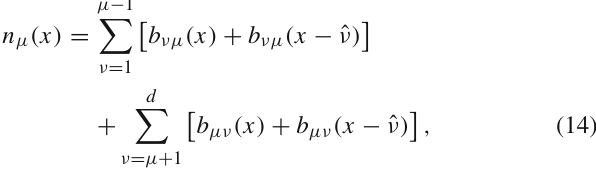
Fig. 1 Representation of the (μ 0 ,ν 0 ) lattice plane. The gauge links ( x ) = U are shown as arrows. The “central plaquette” U μ 0 1 U 2 U 3 U 4 0 ν 0 (in solid red arrows) and the plaquettes which contain any of the links ( x ) . A appearing in U μ i are the staples (in non-solid black lines), 0 0 ν 0 defined in the (μ 0 ,ν 0 ) plane, required to complete the neighboring plaquettes besides the links in the “central